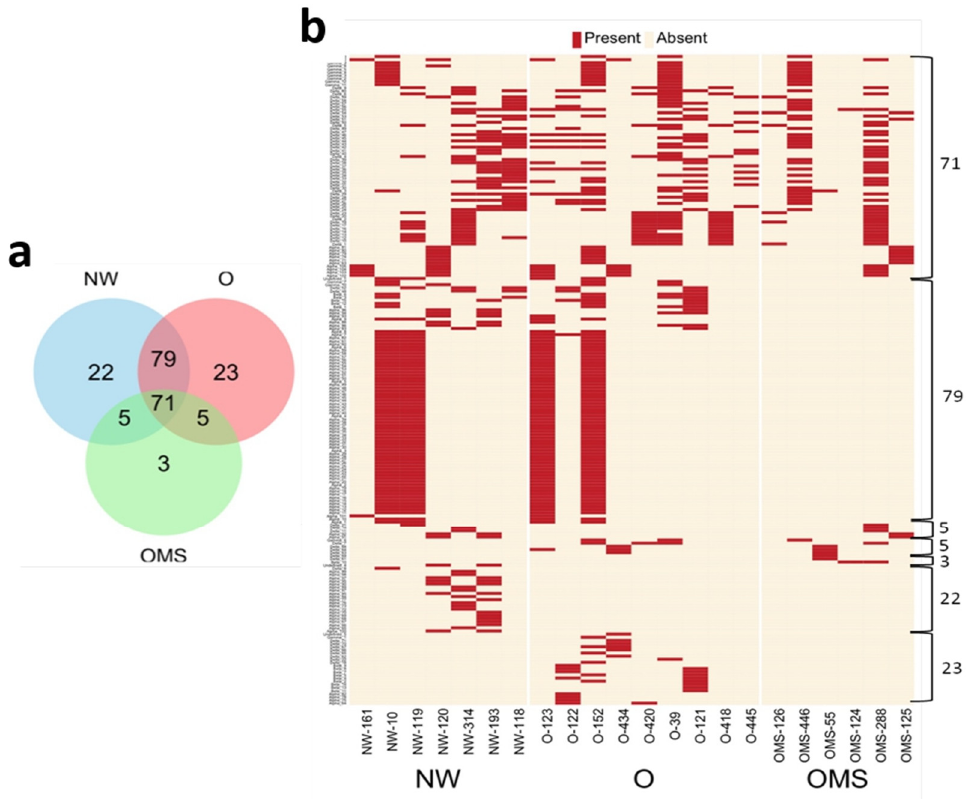
Figure 2. ( a ) Venn diagram of the presence of crAssphage genomes. ( b ) Presence-absence heatmap of crAssphage genomes among all samples, the number of crAssphage genomes from the Venn diagram is marked on the right.